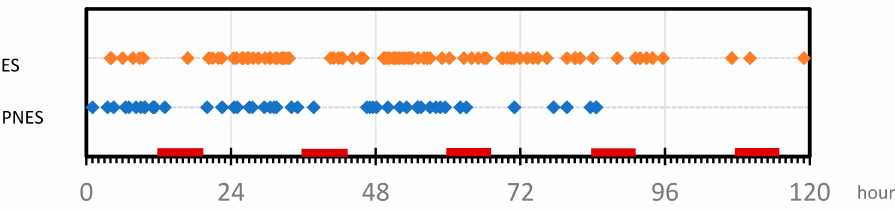
Figure 5. Temporal distribution of the events recorded during the monitoring time. Red marks in time-line indicate night time (from midnight to 7